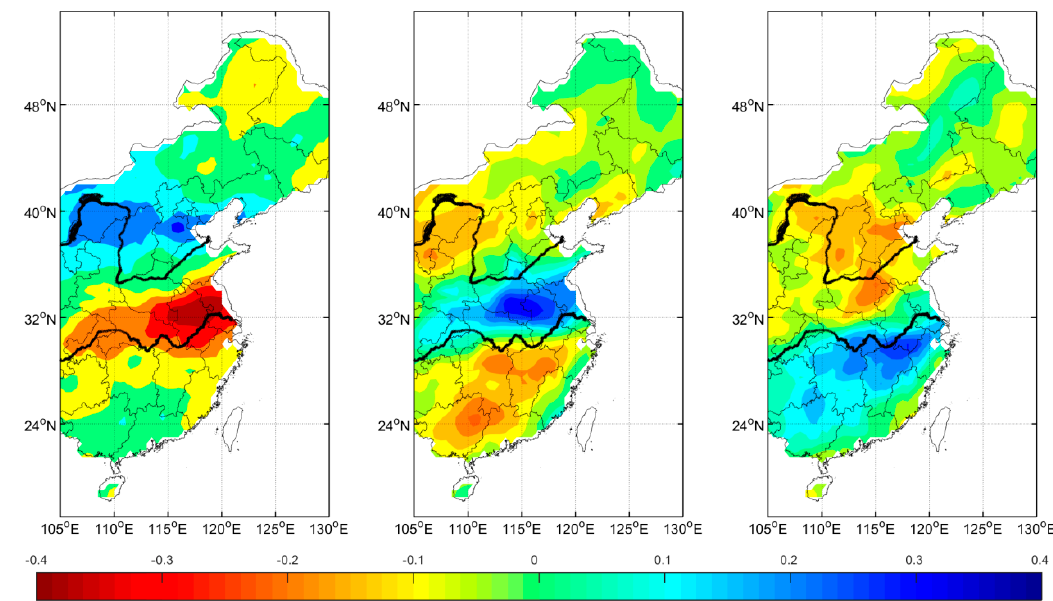
Figure 1. Typical precipitation patterns of class I ( left ), II ( middle ), and III ( right ) over eastern China. The contoured data is the average of the percentage of anomalies of summer precipitation during 1961–2012 for each class according to Table 2, respectively. The thick black line to the north of 32 ◦ N indicates the Yellow River and that to the south indicates the Yangtze River. The original precipitation data is available from a gridded dataset for China (http://data.cma.cn/data/detail/dataCode/SURF_CLI_CHN_PRE_MON_GRID_0.5).